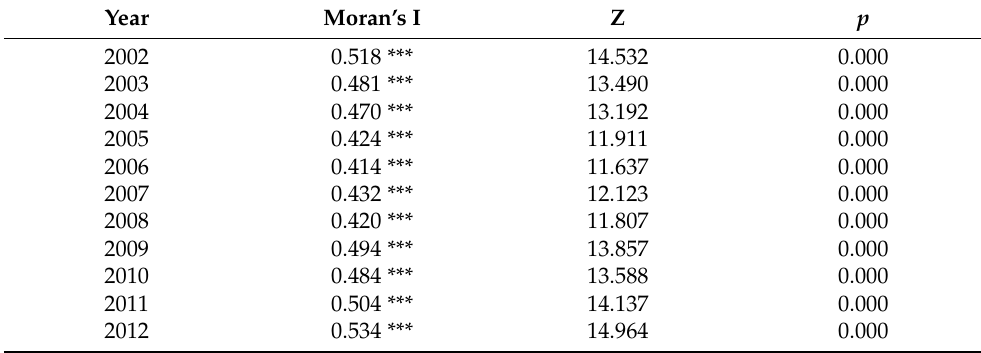
Table A1. Global Moran’s I value and its test results of EEoSLCP in the LP from 2002 to